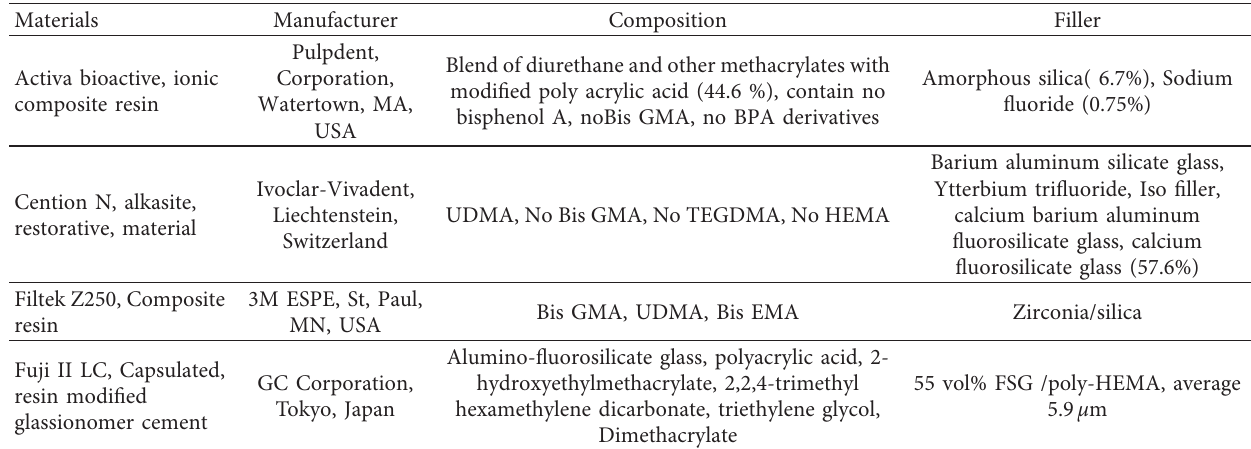
Table 1: Materials and their composition used in this